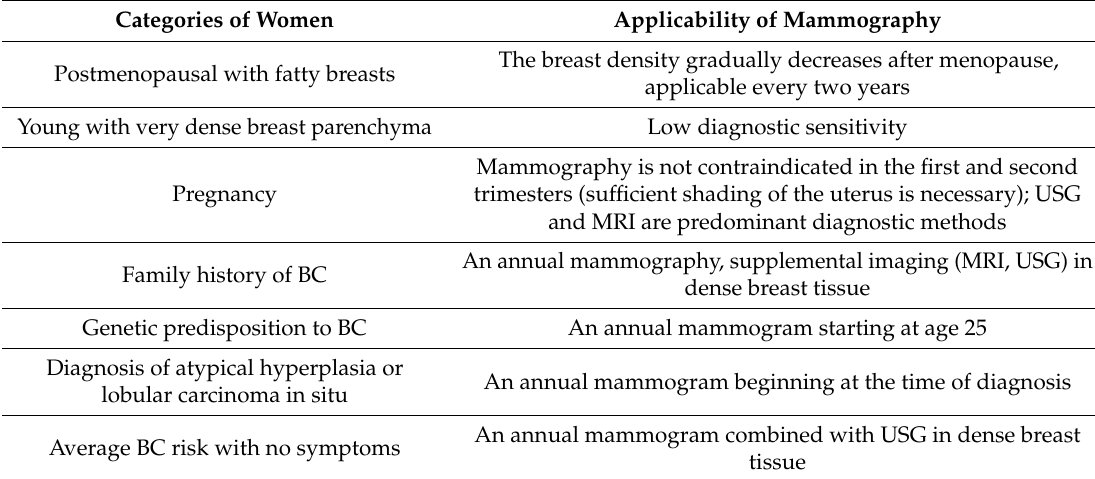
Table 1. Categories of women and mammography screening